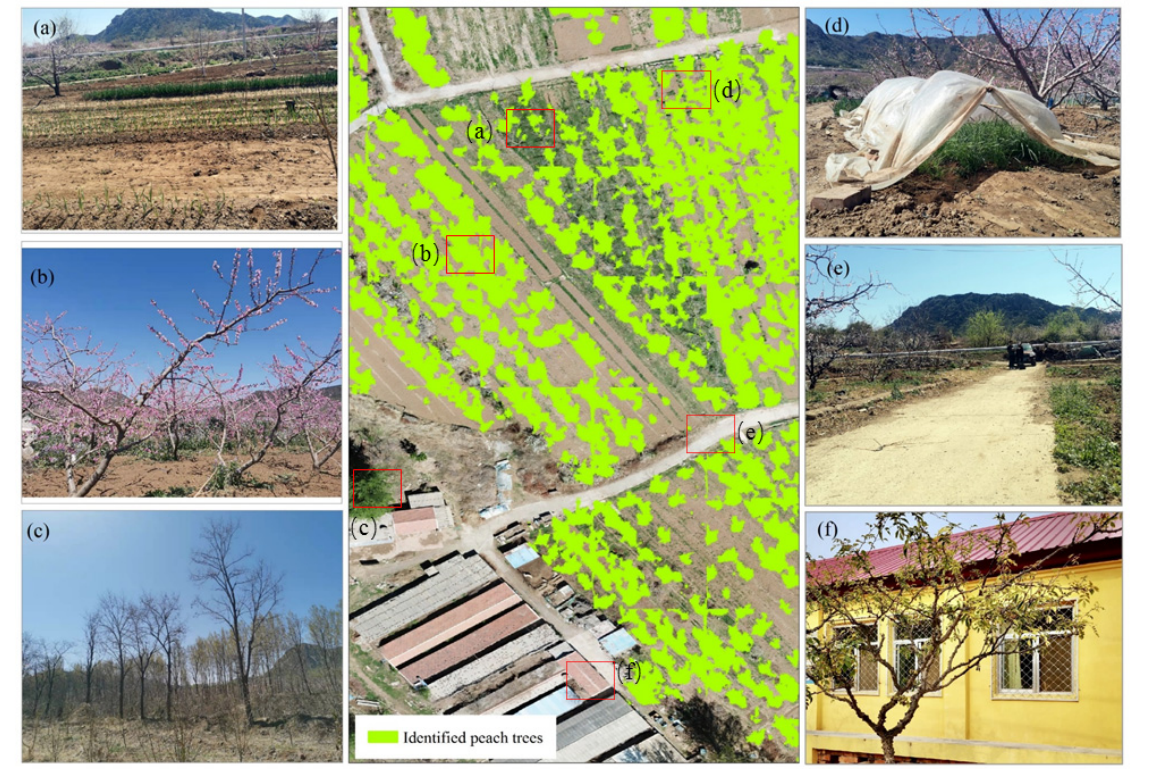
Figure 6. The results of the U-net algorithm: ( a ) peach trees and vegetable fields, ( b ) peach trees, ( c ) windbreaks, ( d ) garlic covered in plastic mulch, ( e ) country road, and ( f ) homestead.